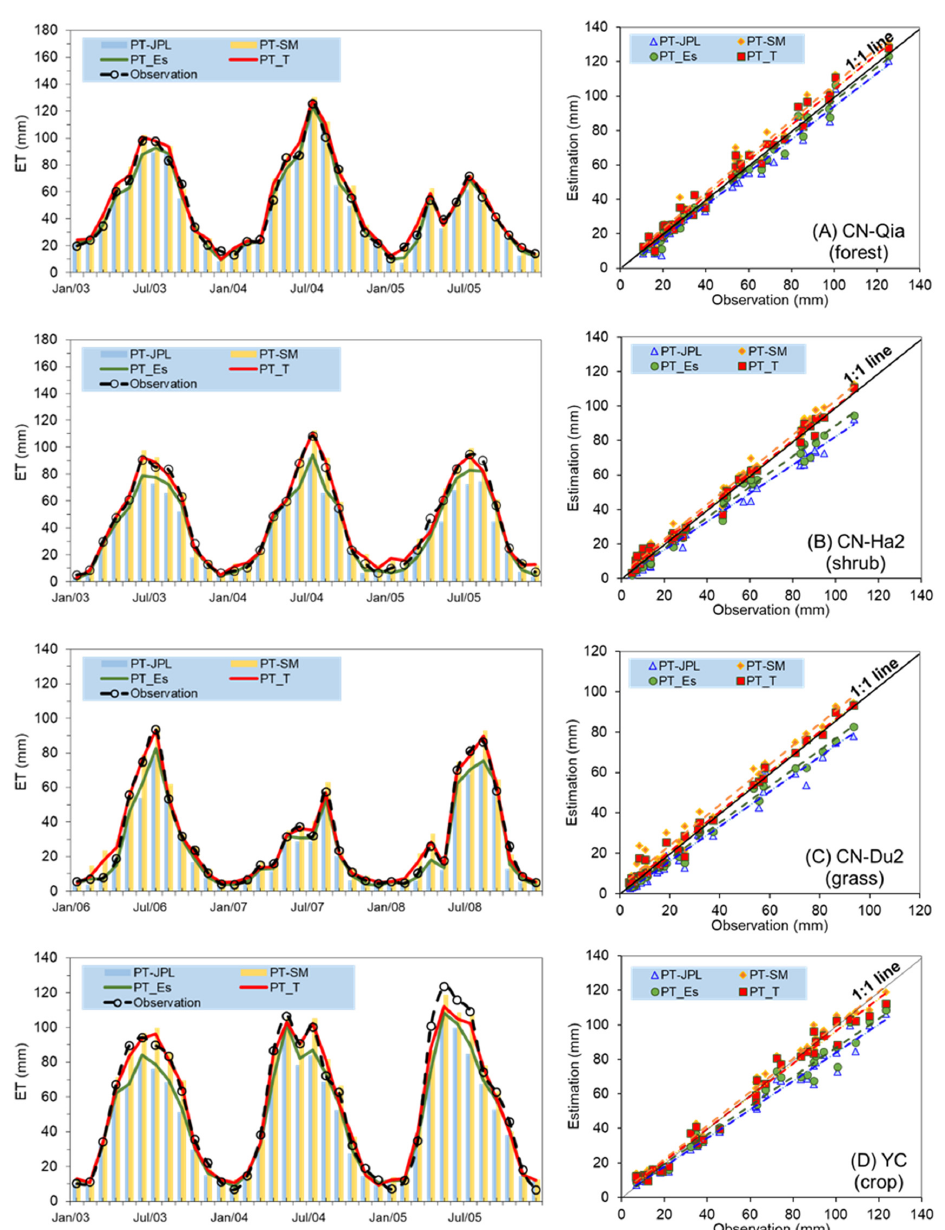
Figure 5. Comparisons of monthly evapotranspiration ( ET ) from observation, original PT–JPL algorithm (PT–JPL), updated algorithm with soil moisture incorporation into soil evaporation (PT_Es), updated algorithm with soil moisture incorporation into transpiration (PT_T), and updated PT-SM algorithm; and scatter plot of ET model without and with soil moisture incorporation into the updated algorithm at ( A ) CN–Qia (forest) flux tower, ( B ) CN–Ha2 (shrub) flux tower, ( C ) CN–Du2 (grass) flux tower, and ( D ) YC (crop) flux tower.